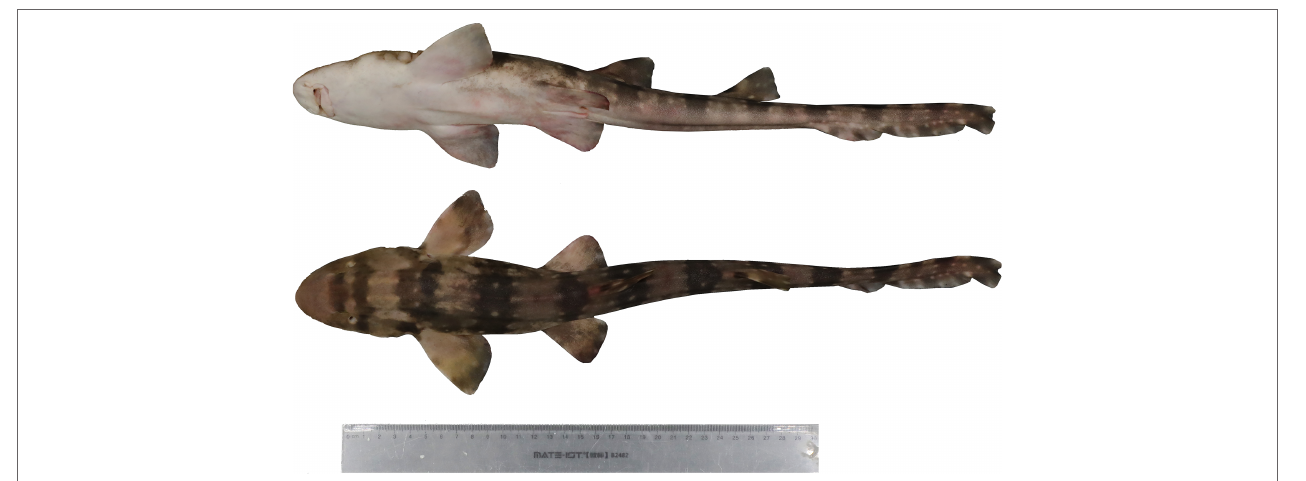
FIGURE 1 | Photograph of Chiloscyllium plagiosum (photo by Yuan